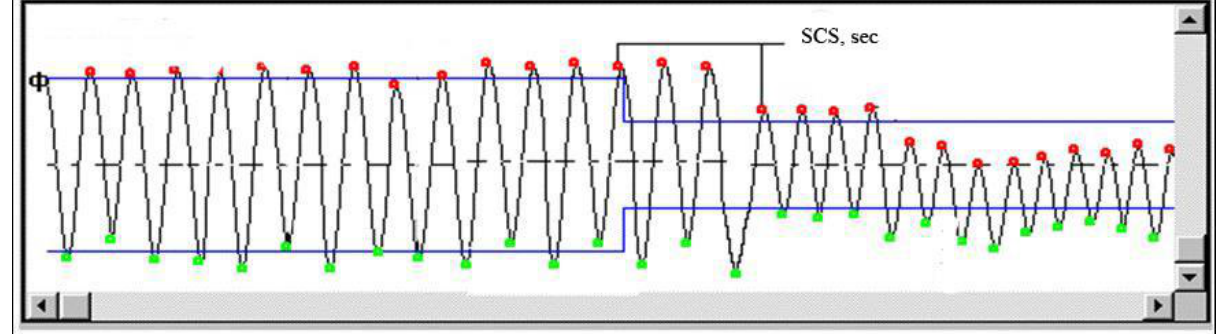
Figure 2. The principle of determining the SCS (sec) in a motion test with use the device “CMM”.